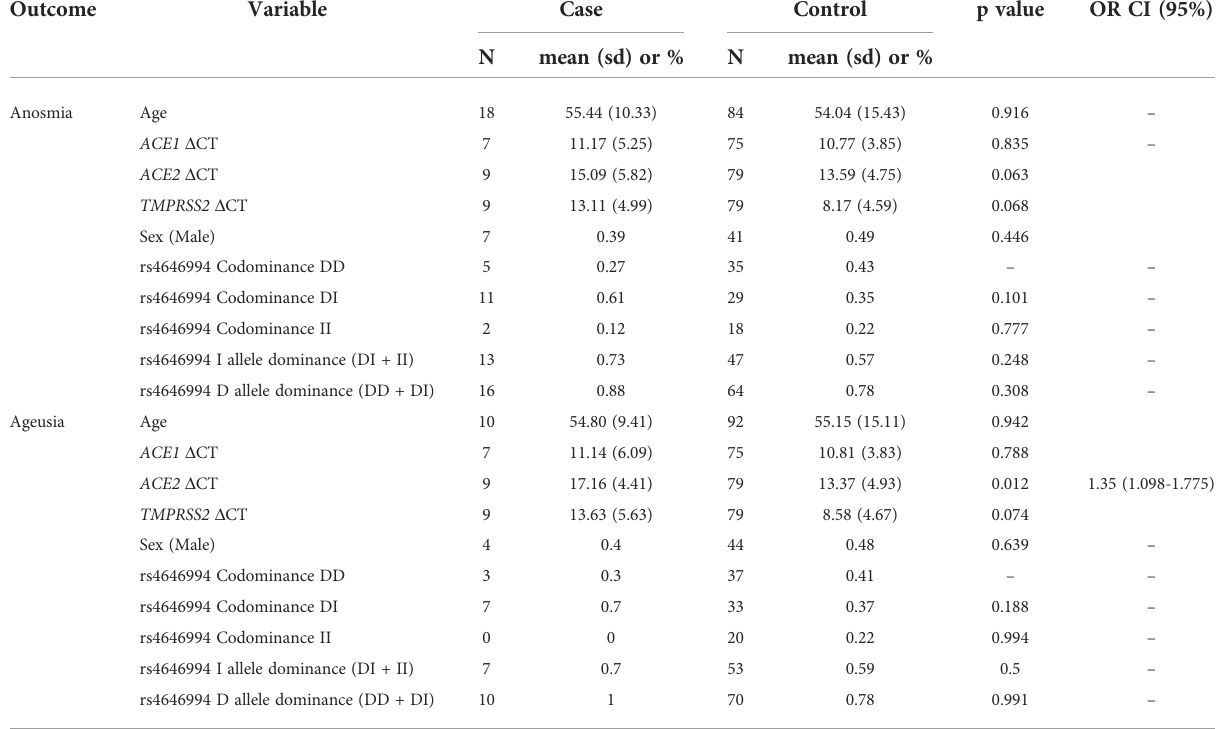
TABLE 3 Logistic regression model for anosmia and ageusia outcomes.